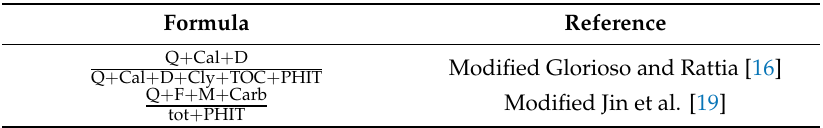
Table 4. Modified MBI correlations showing the total porosity (PHIT) as an additional parameter in the denominator, which decreases the brittleness.